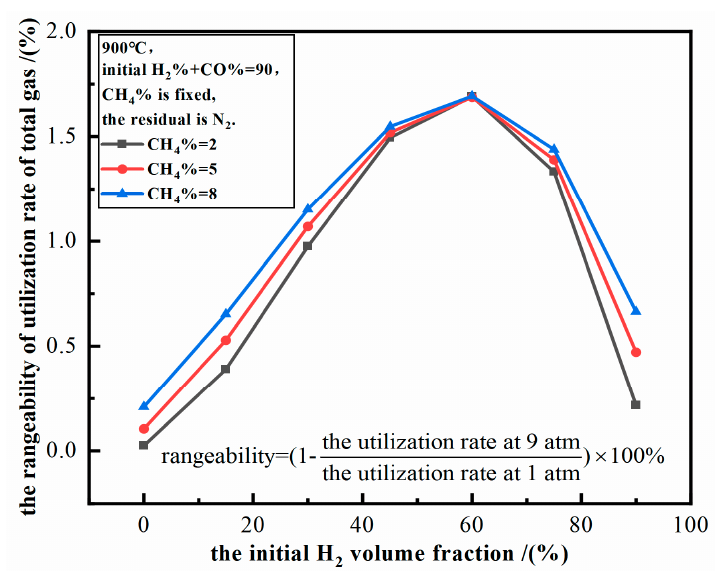
Figure 4. The relationship between the rangeability of the utilization rate of total gas at 900 °C and the initial H 2 volume fraction.